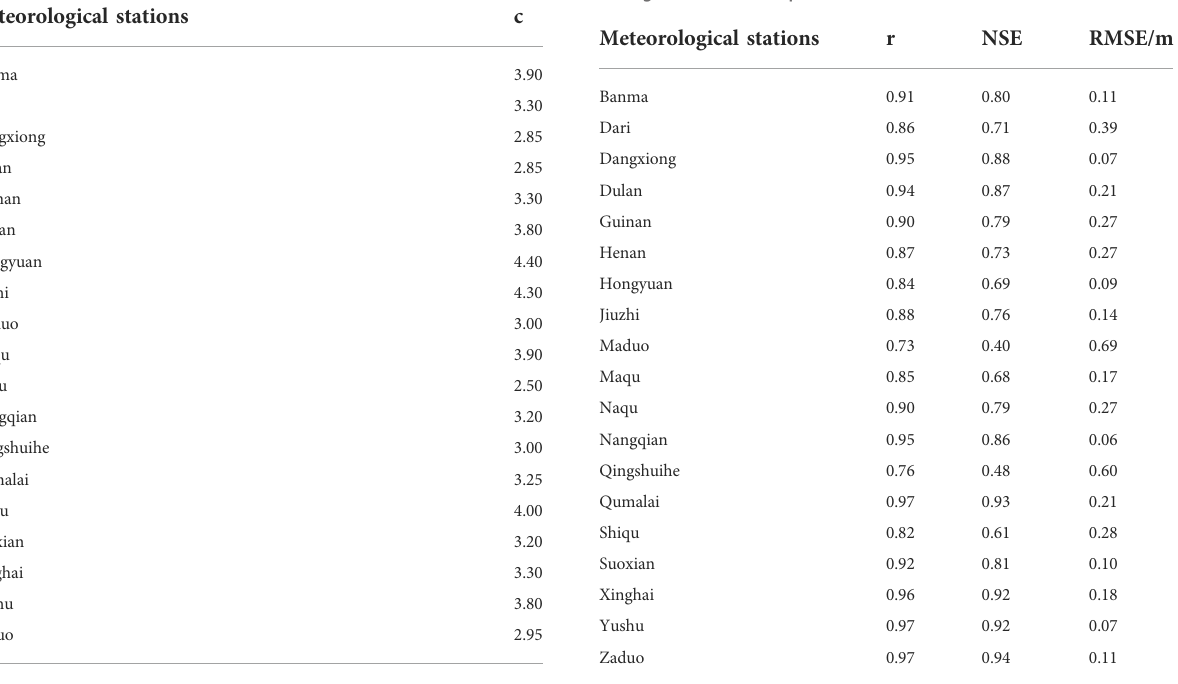
TABLE 1 The model parameters for calibration at 19 meteorological stations in and around TRSR.